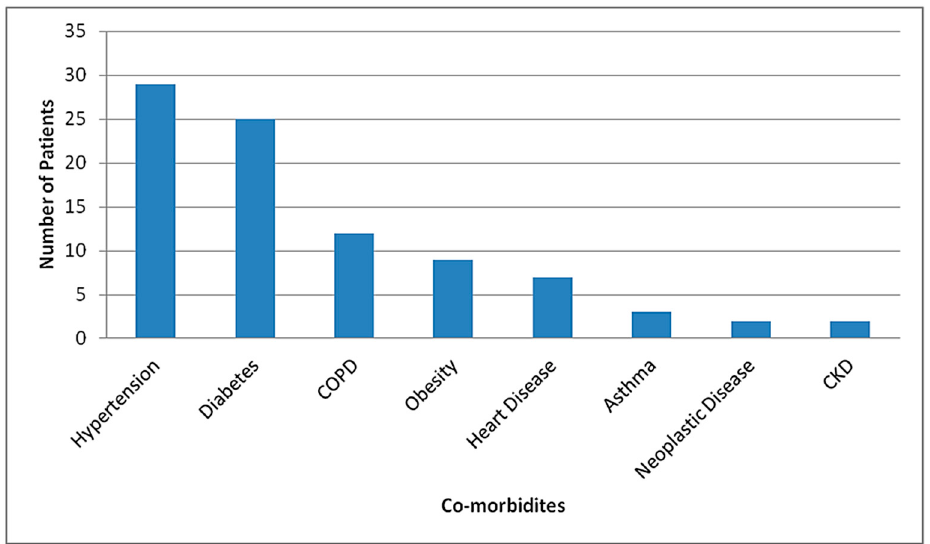
Figure 5. Distribution of co-morbidities among mortalities in STIDH (n = 50). Multiple comorbidities (2 or more) were likely to be present in patients with increasing age with statistically significant association (Table 1). Table 1. Age wise distribution of comorbidities among mortalities in STIDH (n = 50). Multiple (2 or More) Comorbidities Age Group